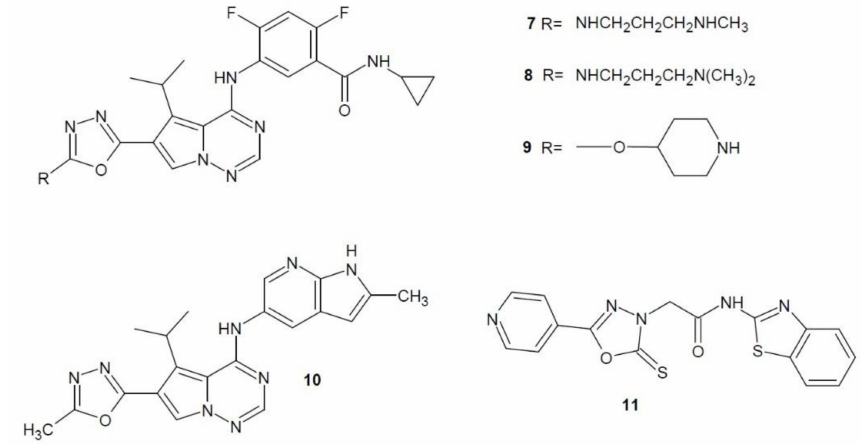
Figure 4. 1,3,4-Oxadiazole derivatives with activity of vascular endothelial growth factor receptor inhibitors.